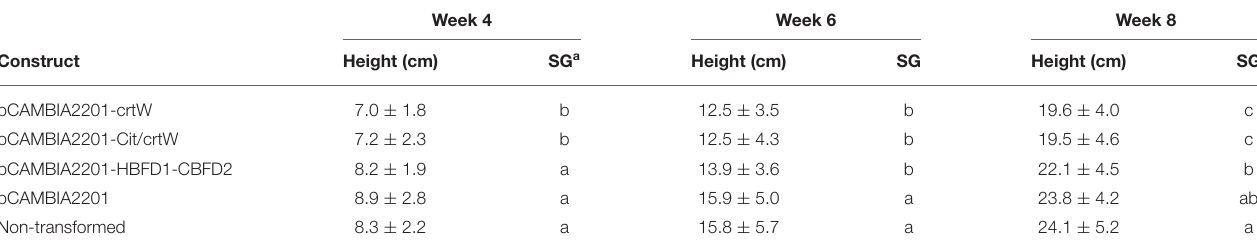
TABLE 3 | Height of T1 N. benthamiana plants at 4, 6 and, 8 weeks after planting grown under greenhouse conditions.